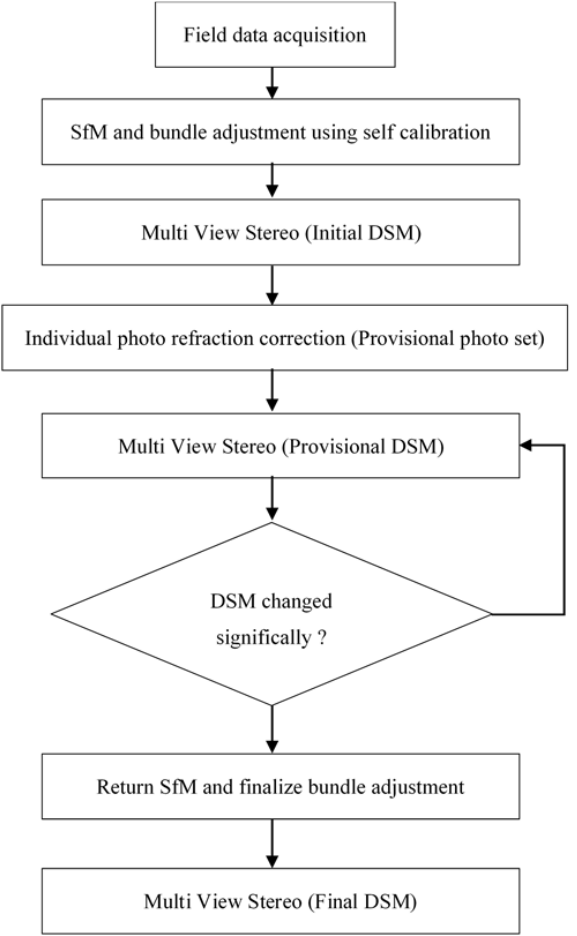
Figure 10. Workflow of iterative water refraction correction of photo level.